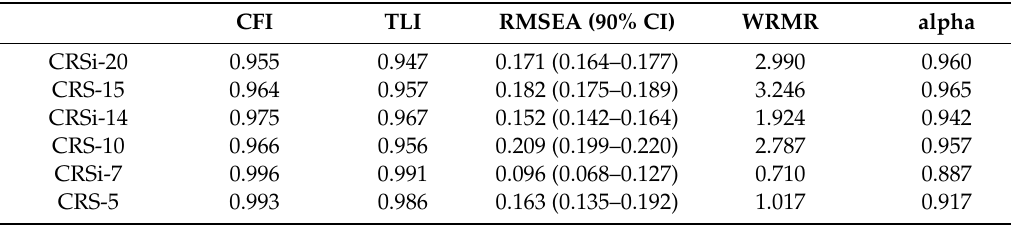
Table A1. Confirmatory factor analysis (CFA) results of unidimensional models of all versions of the Centrality of Religiosity Scale